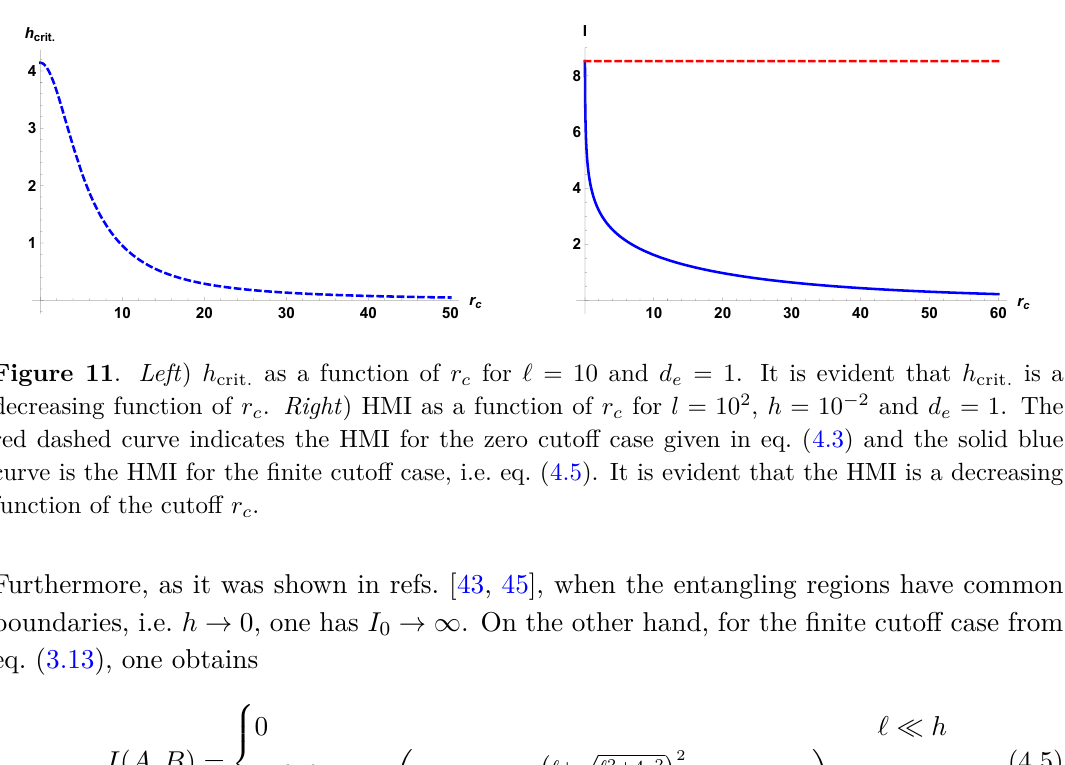
which crit . , where a = R d L d − 1 . a 2 G N r θ F